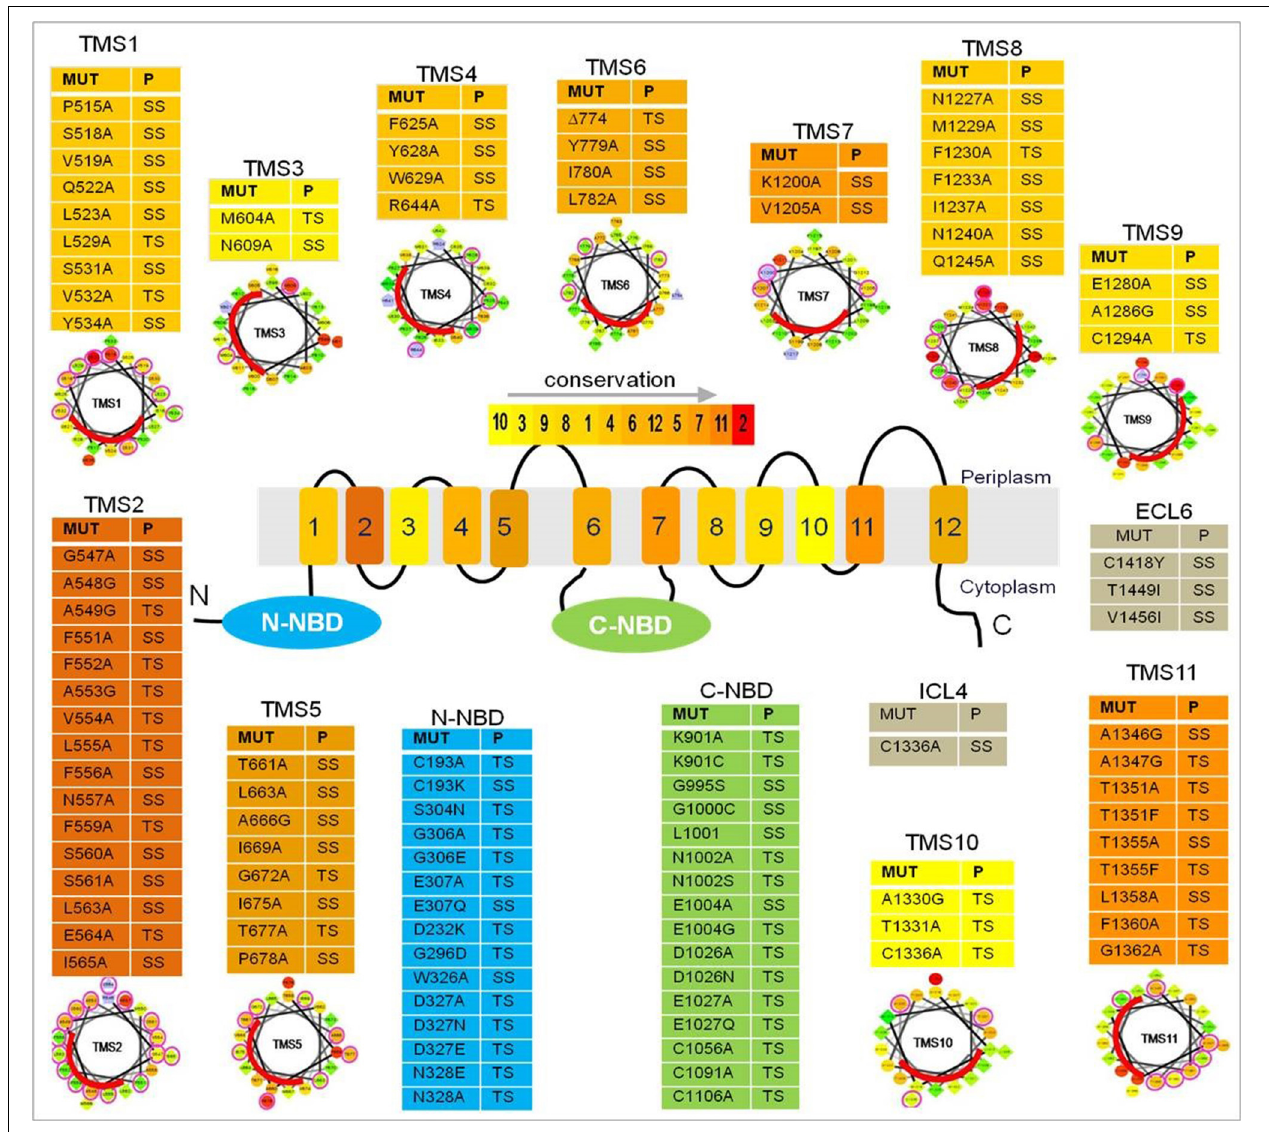
FIGURE 3 | A list of residues from Cdr1p that upon substitution gave a phenotype. The color gradient of individual TMS in the central Cdr1p cartoon shows the relative transmembrane conservation based on conservation scores obtained from JALVIEW2.4.0.b2 (Rawal et al., 2013). A red color indicates the highest conservation score while yellow indicates the lowest score. Abbreviations: MUT (mutants), P (phenotype), TS (susceptible to all drugs), SS (selectively susceptible), ECL (extracellular loop), NBD